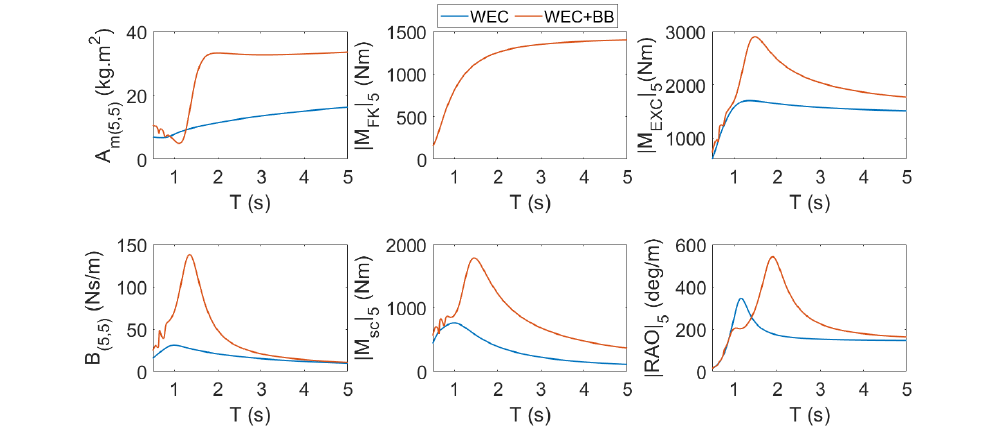
Figure 3. Hydrodynamic quantities evaluated presented in frequency domain using WAMIT for pitch (5th degree of freedom): A m , added mass; B , radiation damping; F FK , Froude-Krylov force modulus; F SC , scattered force modulus; F EXC , excitation force modulus; and RAO , the response amplitude operator. T , is the wave period. Blue lines are data for WEC only, and red lines are data for WEC with bottom